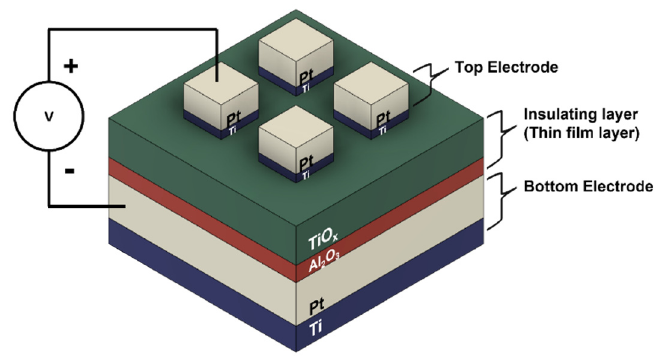
Figure 1. A simple structure of fabricated RRAM device.